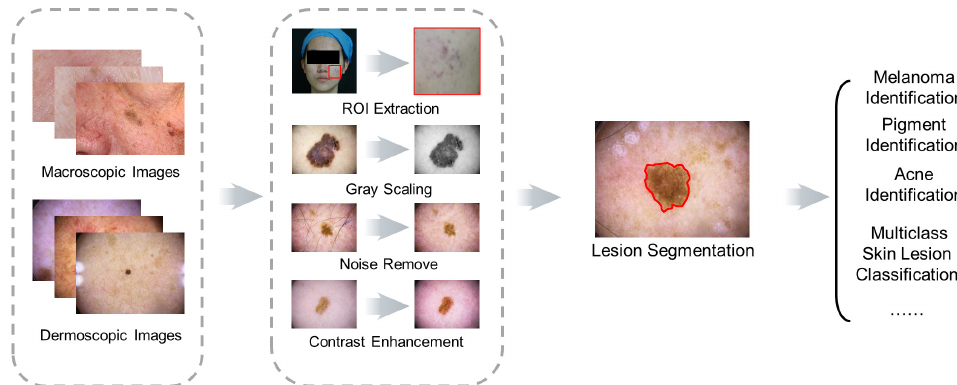
Figure 2. Schematic diagram of skin image